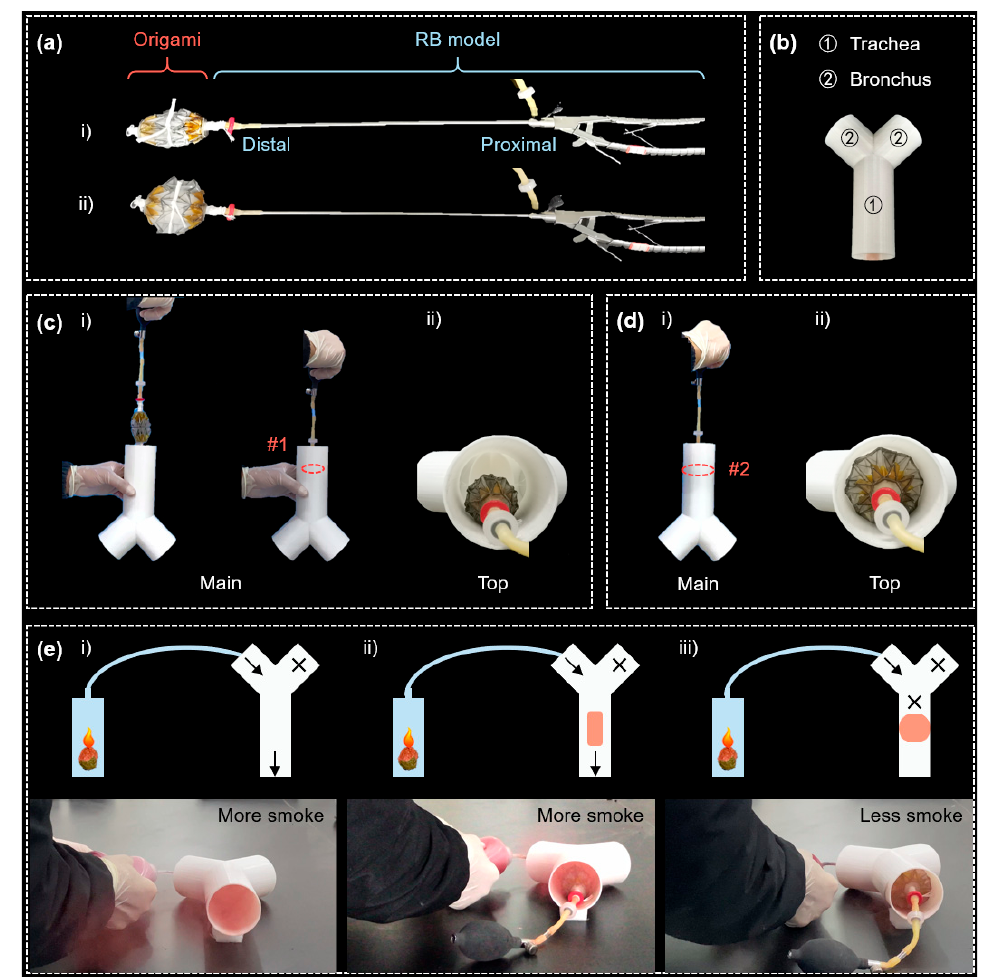
Figure 6. Radial support capability of the Waterbomb. ( a ) Oribron device. (i) when the Waterbomb is at #1, and (ii) when the Waterbomb is at #2. ( b ) Simulated trachea. ( c ) Radial support tests inside the trachea for #1: (i) main view; (ii) top view. ( d ) Radial support tests inside the trachea for #2: (i) main view; (ii) top view. ( e ) Smoke block experiment. From left to right inside the trachea: (i) no obstruction is placed; (ii) place #1; and (iii) place #2.